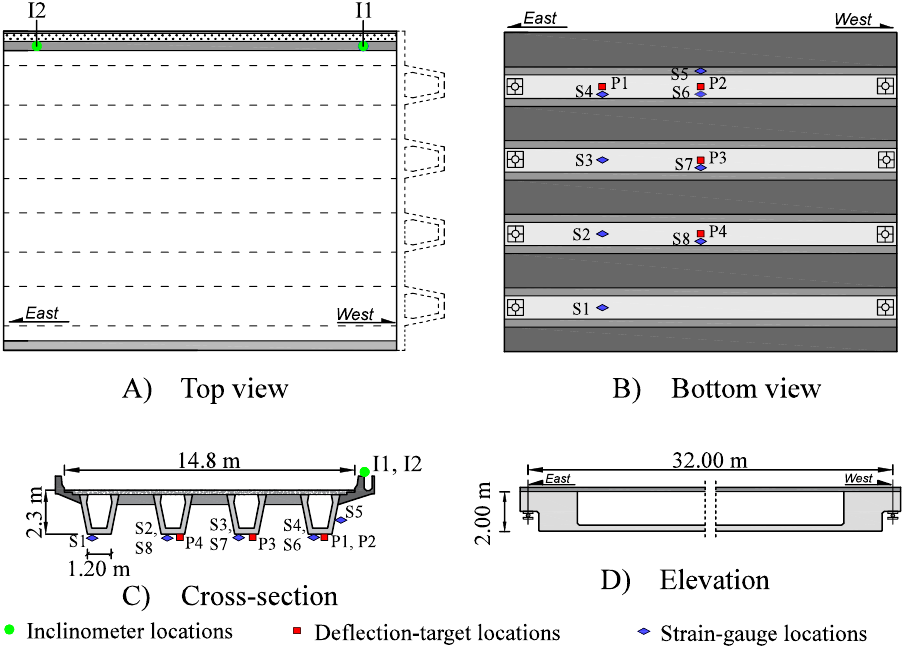
Figure 6. Bridge geometry showing the sensor configuration; ( A ) Top view; ( B ) Bottom view; ( C ) Cross-section; ( D ) Elevation.